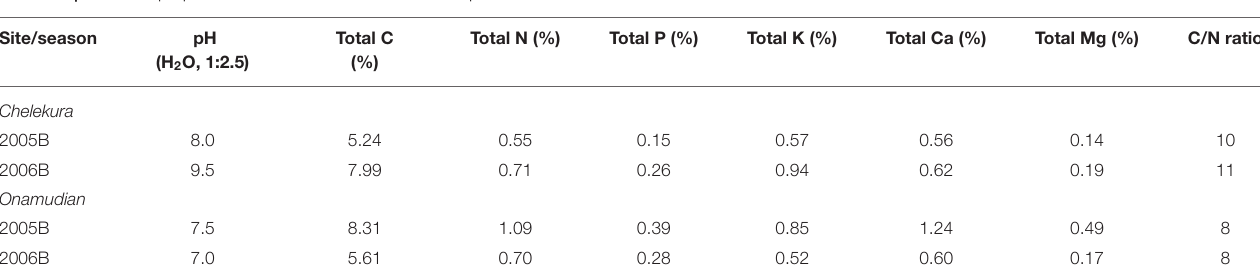
TABLE 2 | Chemical properties of cattle manure used in the